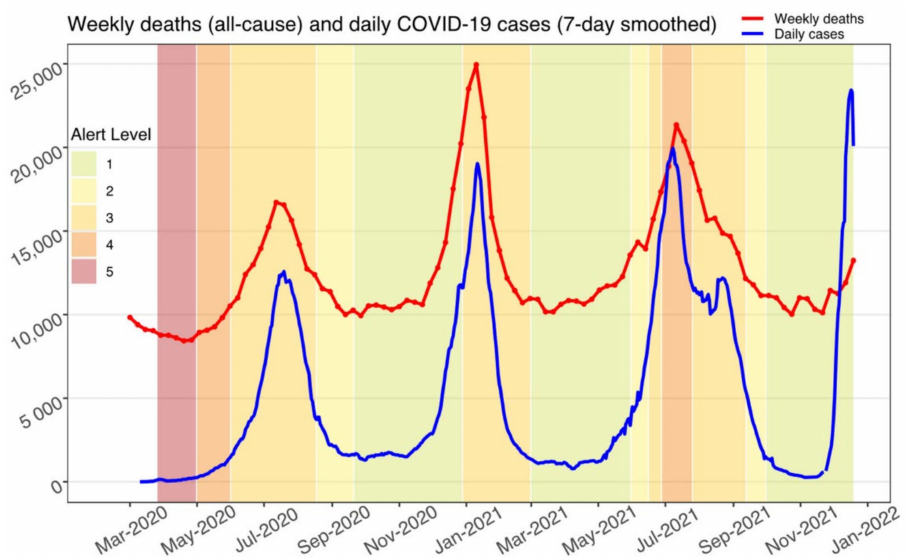
Figure 2. Weekly deaths (all-cause) and new confirmed COVID-19 cases, with shading to indicate the different “alert level” periods in South Africa. (Adapted from sources: